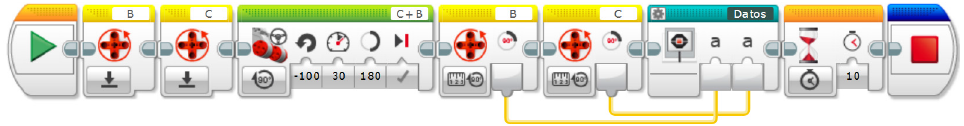
Figure 2. NXT-G program to measure the orientation of the